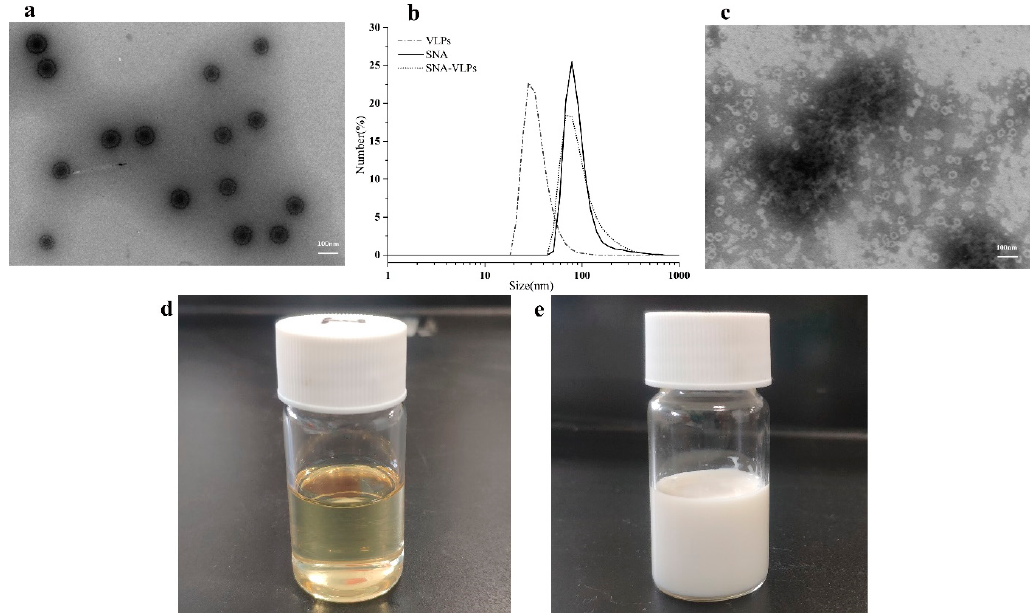
Figure 3. Basic characteristics of the SNA adjuvant. ( a ) The TEM images of the freshly formulated SNA, ( b ) The particle size of the SNA, SNA-VLPs, and FMD-VLPs were measured by DLS. ( c ) The TEM images of the FMD-VLPs. ( d ) A new preparation of SNA. ( e ) A new preparation of the FMD- VLP-SNA vaccine.